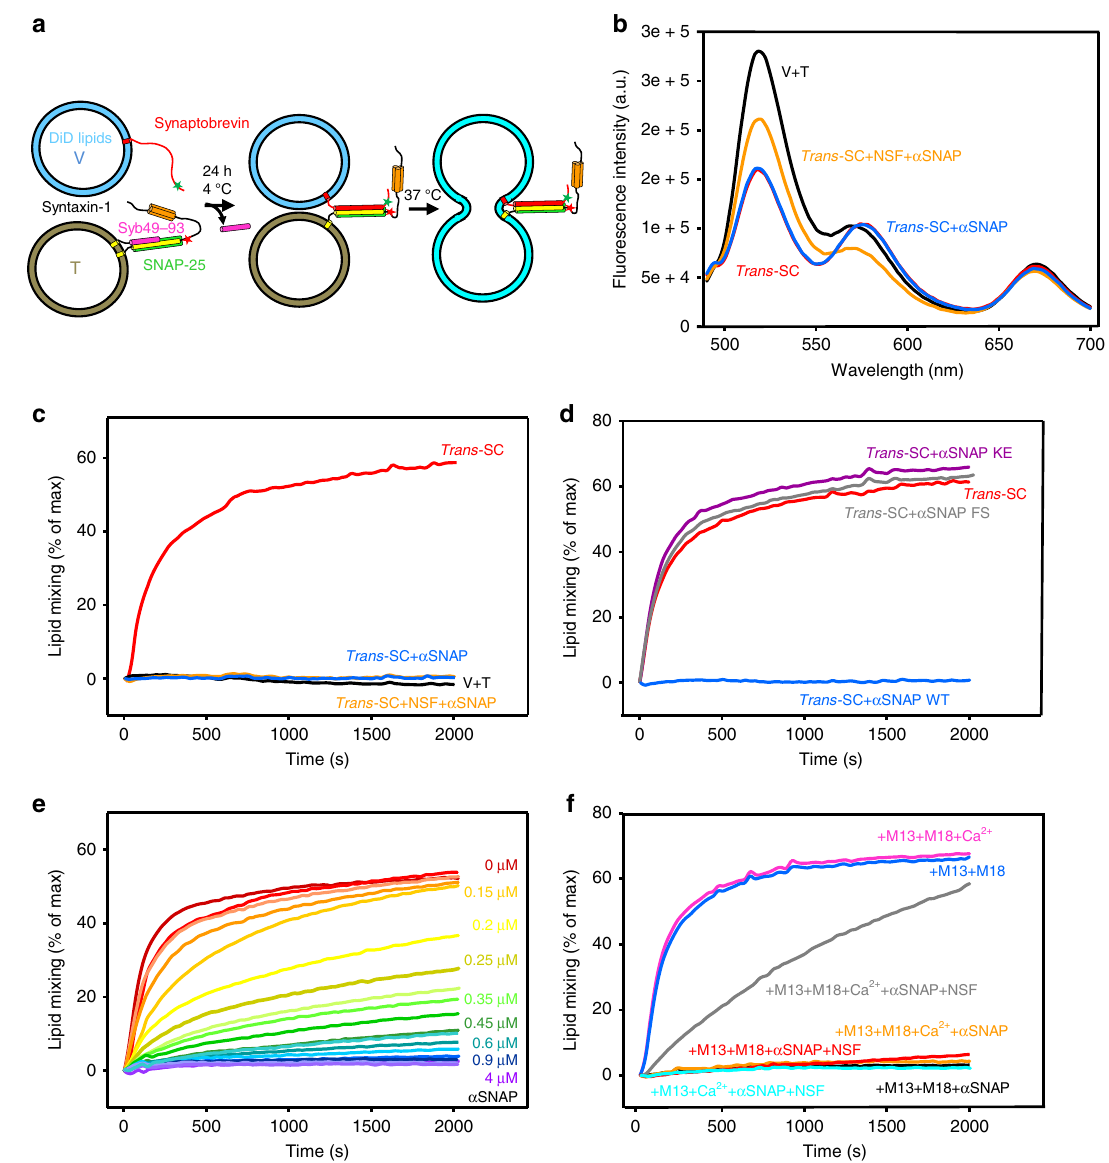
Fig. 10 α SNAP potently inhibits fusion mediated by pre-formed trans -SNARE complexes. a Diagram illustrating the experimental design. The assays monitored the development of FRET between V-liposomes containing Alex488-synaptobrevin and T-liposomes containing tetramethylrhodamine (TMR)- syntaxin-1 and WT SNAP-25 upon trans -SNARE complex assembly. The design is analogous to that of Fig. 6a, but the use of WT SNAP-25 allows liposome fusion. The V-liposomes contained DiD-labeled lipids to monitor lipid mixing from de-quenching of the DiD fl uorescence. V- and T-liposome samples were incubated with Syb49 – 93 for 24 h at 4 °C to promote trans -SNARE complex assembly without liposome fusion, and the temperature was raised to 37 °C after adding various factors to allow lipid mixing. b Fluorescence emission spectra (468 nm excitation) of a mixture of V-liposomes containing Alexa-488- synaptobrevin and T-liposomes containing TMR-syntaxin-1 and WT SNAP-25 (1:4 V- to T-liposome ratio) that had been incubated for 24 h with Syb49 – 93 at 4 °C (red trace) and of the same sample after adding 2 µ M α SNAP (blue trace) or 2 µ M α SNAP plus 0.4 µ M NSF, 2 mM ATP, and 2.5 mM Mg 2 + (orange trace). The black curve shows a control spectrum obtained by adding spectra acquired separately for V- and T-liposomes. c – f Lipid mixing assays performed as summarized in a . De-quenching of DiD fl uorescence was monitored after adding the indicated reagents to the trans -SNARE complexes pre- formed at 4 °C and raising the temperature to 37 °C. c Assays performed with no additions (red trace) or adding 2 µ M α SNAP without (blue trace) or with 0.4 µ M NSF (orange trace). The black trace shows an experiment were the V- and T-liposomes were mixed at 37 °C without pre-incubation at 4 °C. d Assays analogous to those in b with the addition of 2 µ M WT α SNAP or the α SNAP FS or KE mutants. e Assays analogous to those of c with the addition of different concentrations of α SNAP. f Assays analogous to those of c with the addition of different combinations of 1 µ M Munc18-1 (M18), 0.3 µ